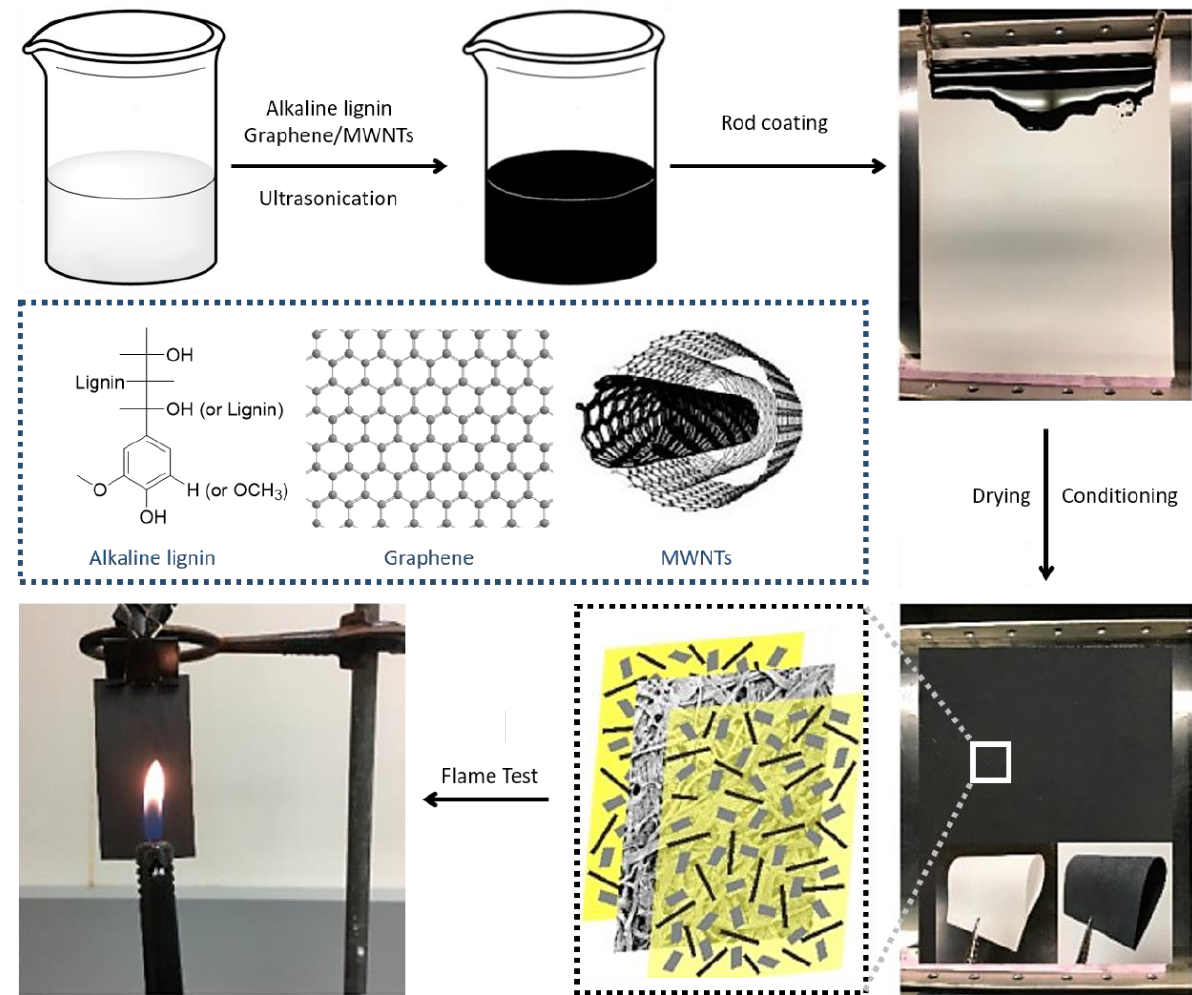
Figure 20. Schematic showing the fabrication of graphene nanoplatelets (GNP)/MWNT/lignin-coated paper using ultra- sonication and rod coating and a flame test of the fabricated paper. Reprinted with permission from Ref. [175]. Copyright 2017, MDPI AG.